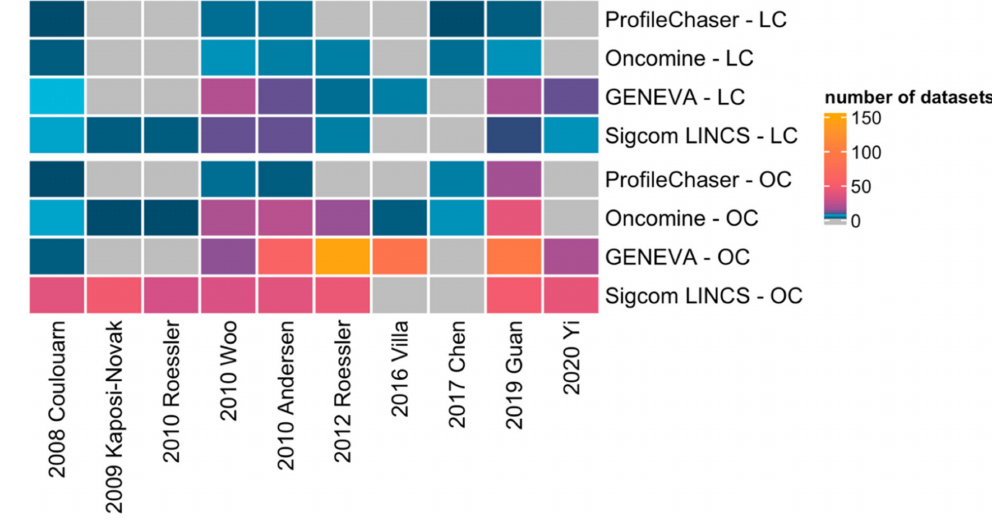
Figure 2. HCC gene signature search results of four bio-tools. LC: Liver Cancer, OC: Other Can- cers. The color represents the number of datasets matched in each tool; grey mean no datasets matched [10,11,16–23].